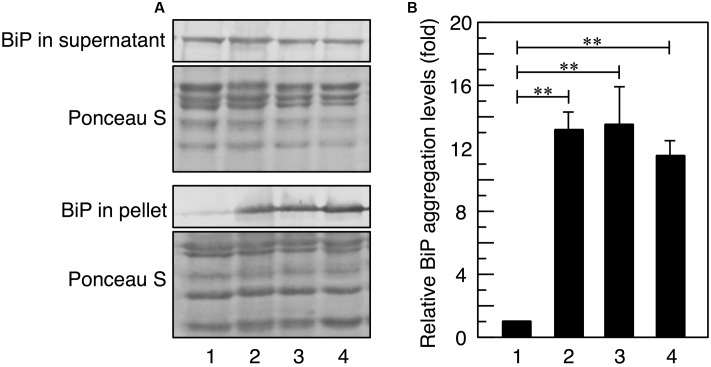
BiP aggregation upon acetic acid stress. Exponentially growing cells were exposed to stress with acetic acid or 10 mM DTT for 3 h and lysed using glass beads in Triton X-100-containing buffer. (A) Total cell lysates were fractionated into the supernatant and pellet fractions by centrifugation and analyzed using an anti-BiP antibody. Protein loading abundance was verified and normalized by Ponceaus S staining. (B) Protein levels of BiP in the pellet fraction were quantified using ImageJ, and the intensity of the BiP band in cells treated without stress was considered to be 1-fold. Data are shown as the mean ± standard error (n = 3). Lane 1, w/o stress; lane 2, 0.2% acetic acid; lane 3, 0.3% acetic acid; lane 4, 10 mM DTT. ∗∗P-value < 0.01.